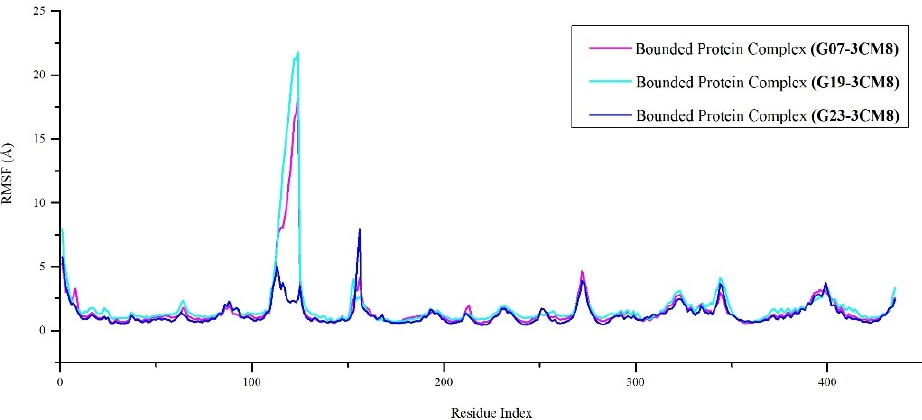
Figure 10. The RMSF curves of G07 − 3CM8, G19 − 3CM8 and G23 − 3CM8 during 100 ns simulations.